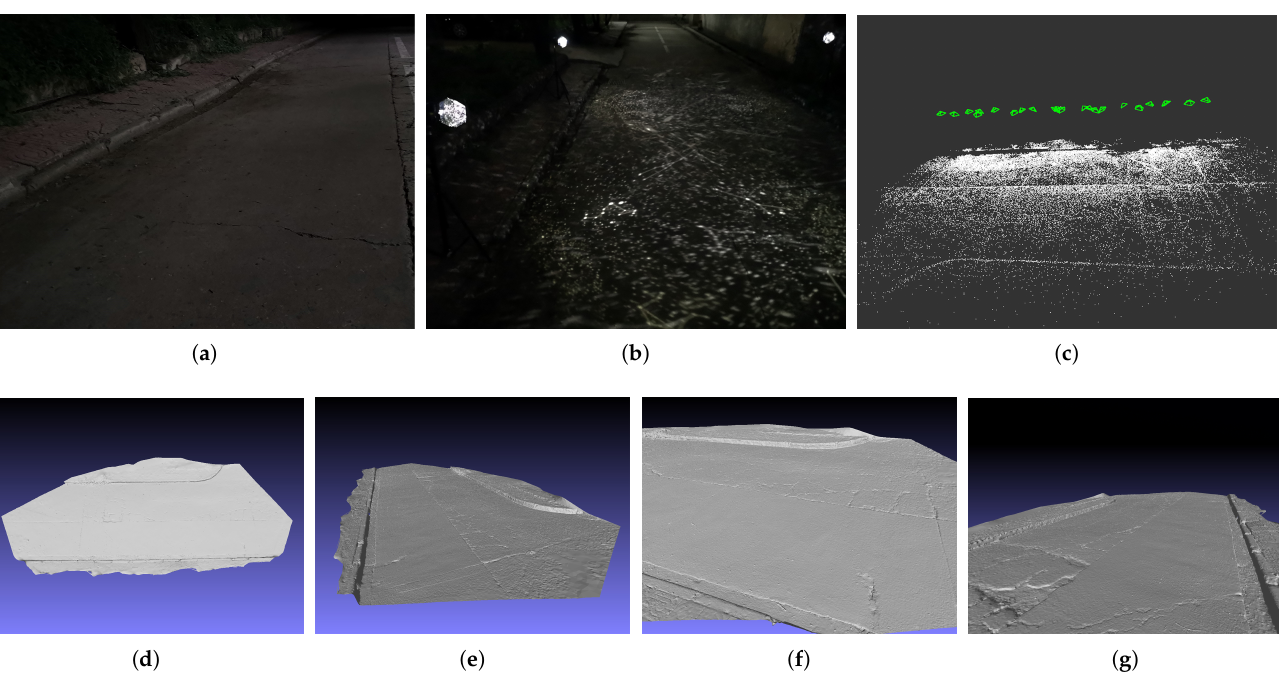
Figure 14. Reconstruction of a part of pavement at night. ( a ) The actual scene; ( b ) Light sources and the pavement with the spark pattern; ( c ) Sparse reconstruction and the camera poses; ( d – g ) Different views of a part of the reconstructed pavement.